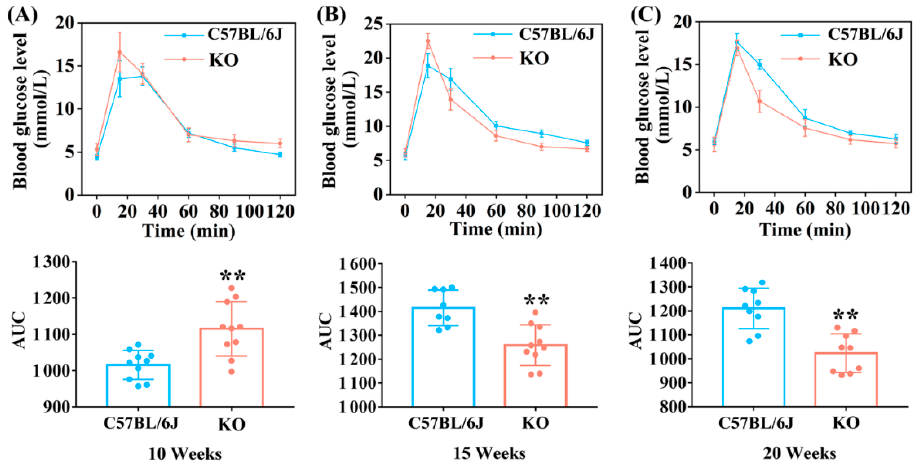
Figure 2. GTT (Glucose tolerance test) of SELENOF KO and C57BL/6J mice at different ages. ( A ) GTT detected at 10 weeks ( n = 10). ( B ) GTT detected at 15 weeks ( n = 8 for C57BL/6J mice and n = 10 for KO mice). ( C ) GTT detected at 20 weeks ( n = 9). Area under curve (AUC) value was calculated. Data were expressed as mean ± SD. ** p < 0.01, compared with C57BL/6J mice. ITT is used to evaluate the activity of insulin and insulin sensitivity of the body [28].